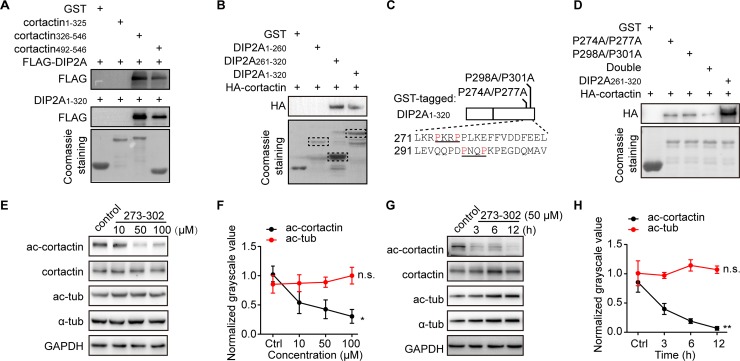
The DIP2A-cortactin interaction is critical for mediating ac-cortactin.(A) The SH3 domain of cortactin (aa 492–546) was required for binding with DIP2A in the GST pull-down assay. (B) The binding assay demonstrated that the DIP2A261–320 region with PXXP motifs was large enough to bind cortactin. (C) Diagram of GST-tagged DIP2A1–320 with site mutation strategies. Residues 271–310 with PXXP motifs are aligned below. (D) DIP2A-cortactin binding was minimally detectable when both PXXP motifs were simultaneously mutated (double). (E and F) Ac-cortactin levels were decreased in a concentration-dependent pattern (ac-cortactin, Pearson correlation = −0.656, *P = 0.0205; ac-tub, Pearson correlation = 0.279, n.s. P = 0.3798). (G and H) Ac-cortactin levels were decreased in time-dependent patterns (ac-cortactin, Pearson correlation = −0.814, **P = 0.0013; ac-tub, Pearson correlation = 0.181, n.s. P = 0.5729). The underlying data for this figure can be found in S1 Data. aa, amino acid; ac-cortactin, cortactin acetylation; DIP2A, disconnected-interacting protein homolog 2 A; FLAG, FLAG tag with the sequence DYKDDDDK; GAPDH, glyceraldehyde 3-phosphate dehydrogenase; GST, glutathione S-transferase tag; HA, human influenza hemagglutinin tag (YPYDVPDYA-tag); n.s., no significance; PXXP, proline-rich motif, where X is any residue; SH3, src homology 3; tub, tubulin.